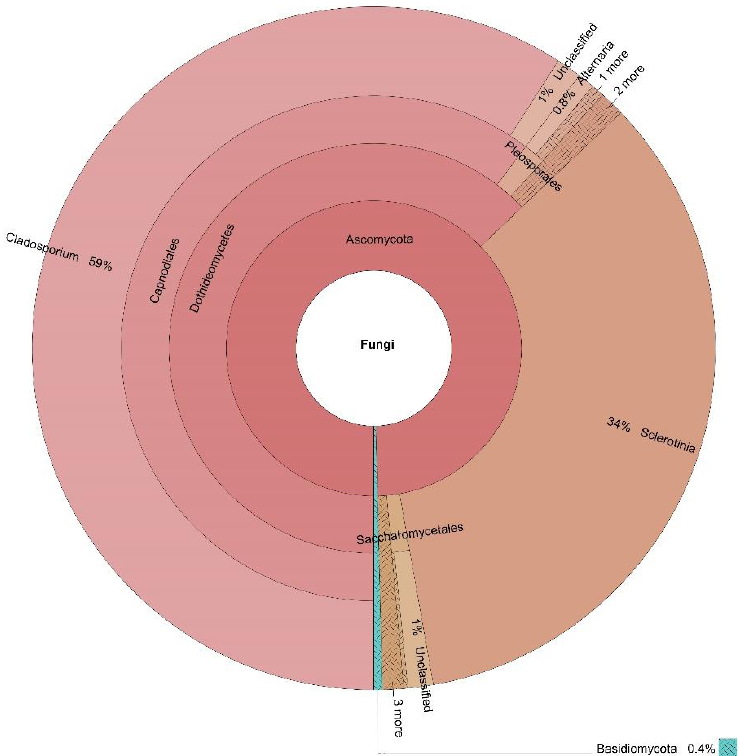
J. Fungi 2021 , 7 , x FOR PEER REVIEW Figure 3 . Krona display of the fungal composition of the samples from Momchilovtzi. Figure 3. Krona display of the fungal composition of the samples from Momchilovtzi.